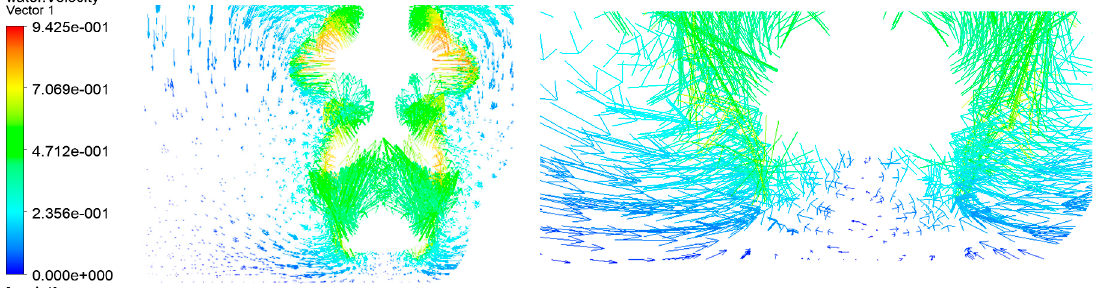
Figure 8. Velocity vector of the flow field in the micro-machining gap.